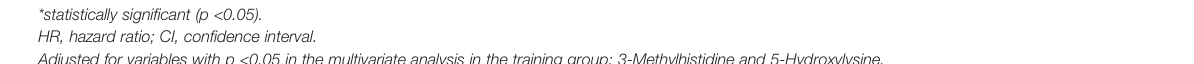
TABLE 2 | Adjusted hazard ratios and 95% con fi dence intervals for variables associated with overall survival in the validation group. Variable